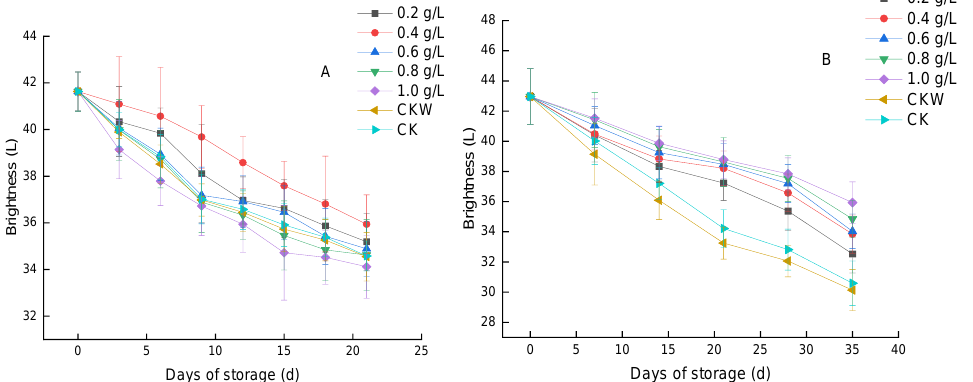
Figure 4. Effects of different Lycium barbarum leaf extract concentrations on the brightness (L) of cherry tomatoes at 20 °C ( A ) and 5 °C ( B ). 3.5. Effects of Different Lycium barbarum Leaf Extract Concentrations on the Firmness of Cherry Tomatoes